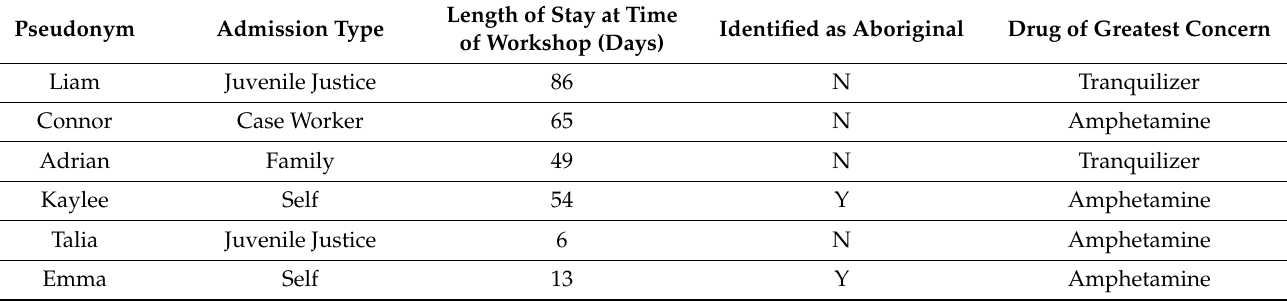
Table 1. Characteristics of Interviewed